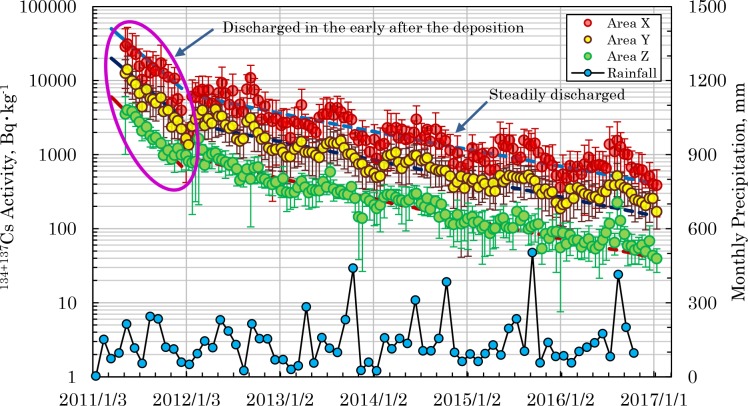
Temporal changes of the 134+137Cs radioactivity in the incineration ash and monthly precipitation.